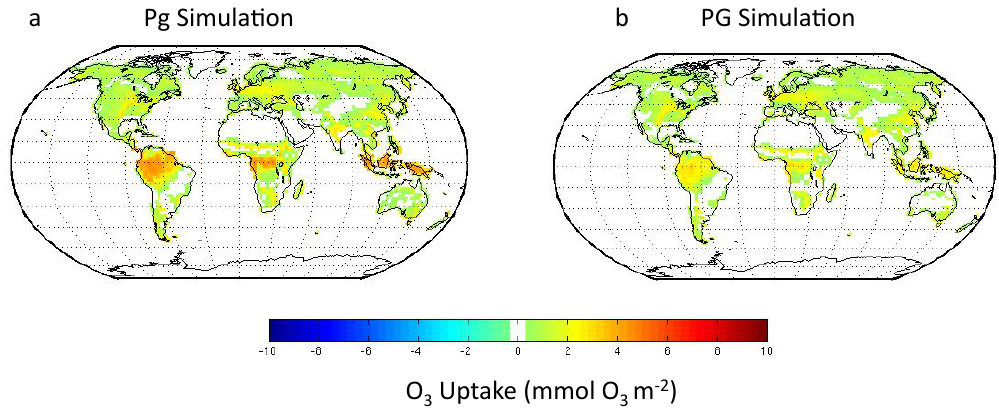
Figure 6 Fig. 6. Mean annual O 3 uptake predicted in 20-yr CLM simulations run at 100ppb O 3 in the (a) Pg simulation, where a direct change in photosynthesis causes changes in conductance and for the (b) PG simulation, where direct changes to photosynthesis and conductance occur independently. Ozone uptake is calculated as a function of O 3 concentration and stomatal conductance integrated over